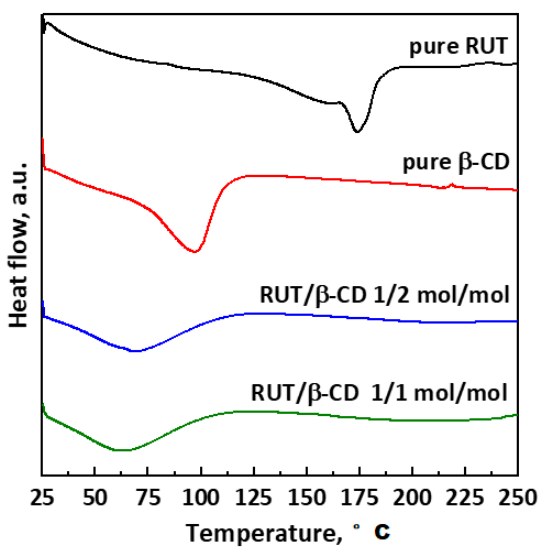
Figure 8. DSC thermograms of unprocessed RUT, unprocessed β -CD, and SAS-processed RUT– β -CD powders at different molar ratios.